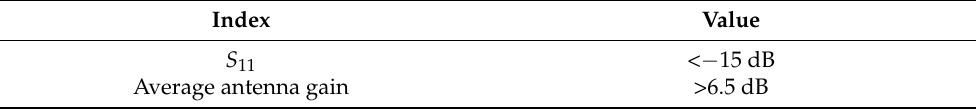
Table 1. Objective function